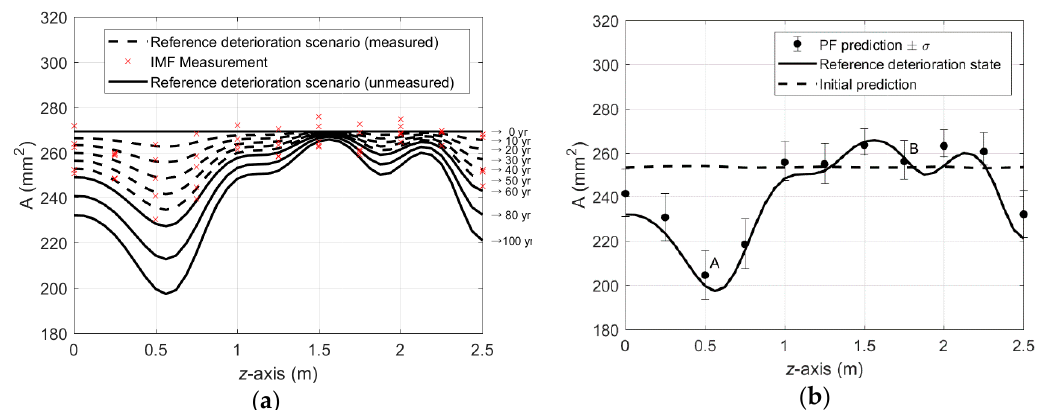
Figure 4. Generated reference scenario and prediction by particle filter approach: ( a ) Reference deterioration scenario and noisy periodic measurements; ( b ) Prediction by particle filter approach for 100th year of the operation.